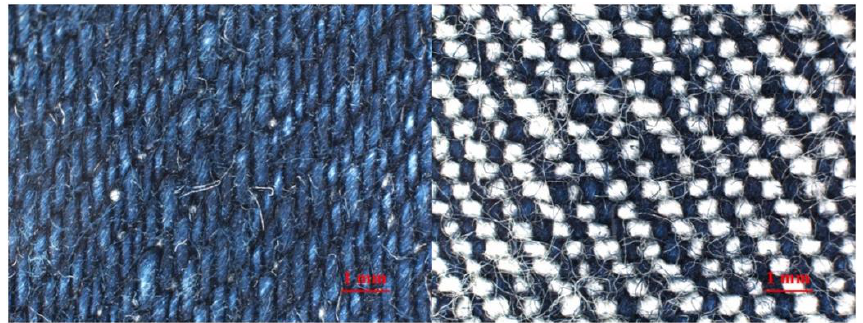
Figure 3. Structure of denim fabric on the outer side ( left image ) on the inner side ( right image ). One of the most characteristic features of denim yarn is ring dyeing; fibres are woven into thread and then dyed. It results in such an effect, that only an outer layer of thread consists of colored fibres and the core of the thread remains white. Due to this particular technological process, the denim fibres are dyed unevenly and exhibit high intra-subject and inter-object variability, as shown in Figure 4.